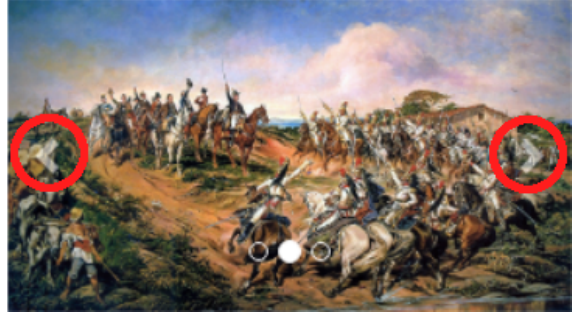
Fig. 4. Slideshow issues.